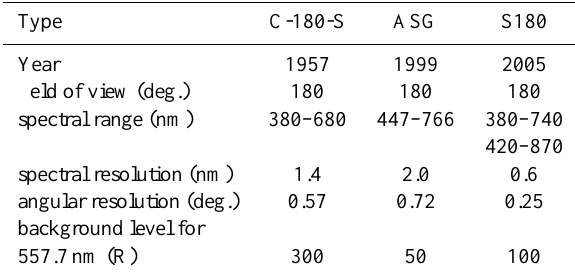
Table 2. Spectrograph’s parameters